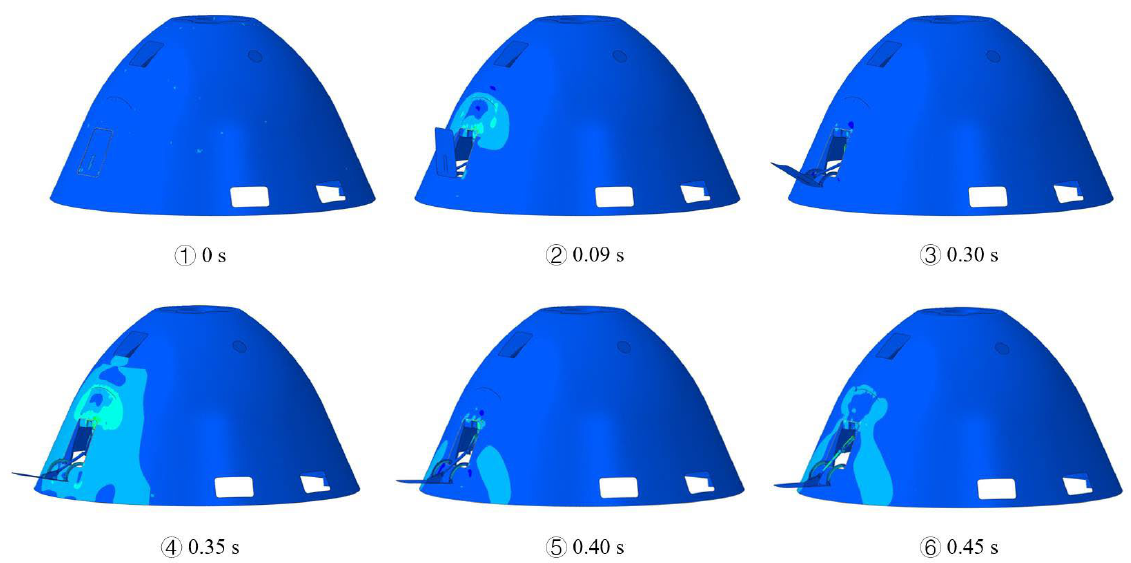
Figure 15. Deployment process of the trim flap system installed on the backshell.